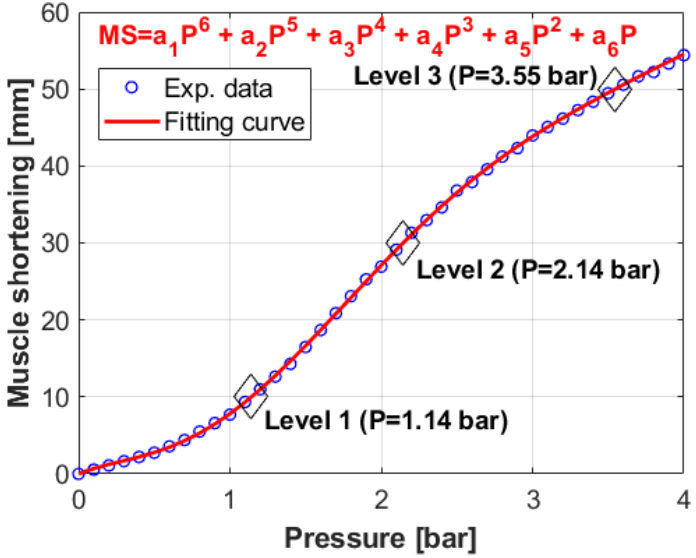
Figure 10. Characteristic and fitting curves of the tested Festo MAS-20-300. In the equation of the fitting curve of muscle shortening (MS), as function of the pressure (P), a1 = − 0.1373, a2 = 1.9254, a3 = − 9.895, a4 = 21.261, a5 = − 13.41, a6 = 8.0658. The three diamond markers represent the three MS levels and the corresponding P values.